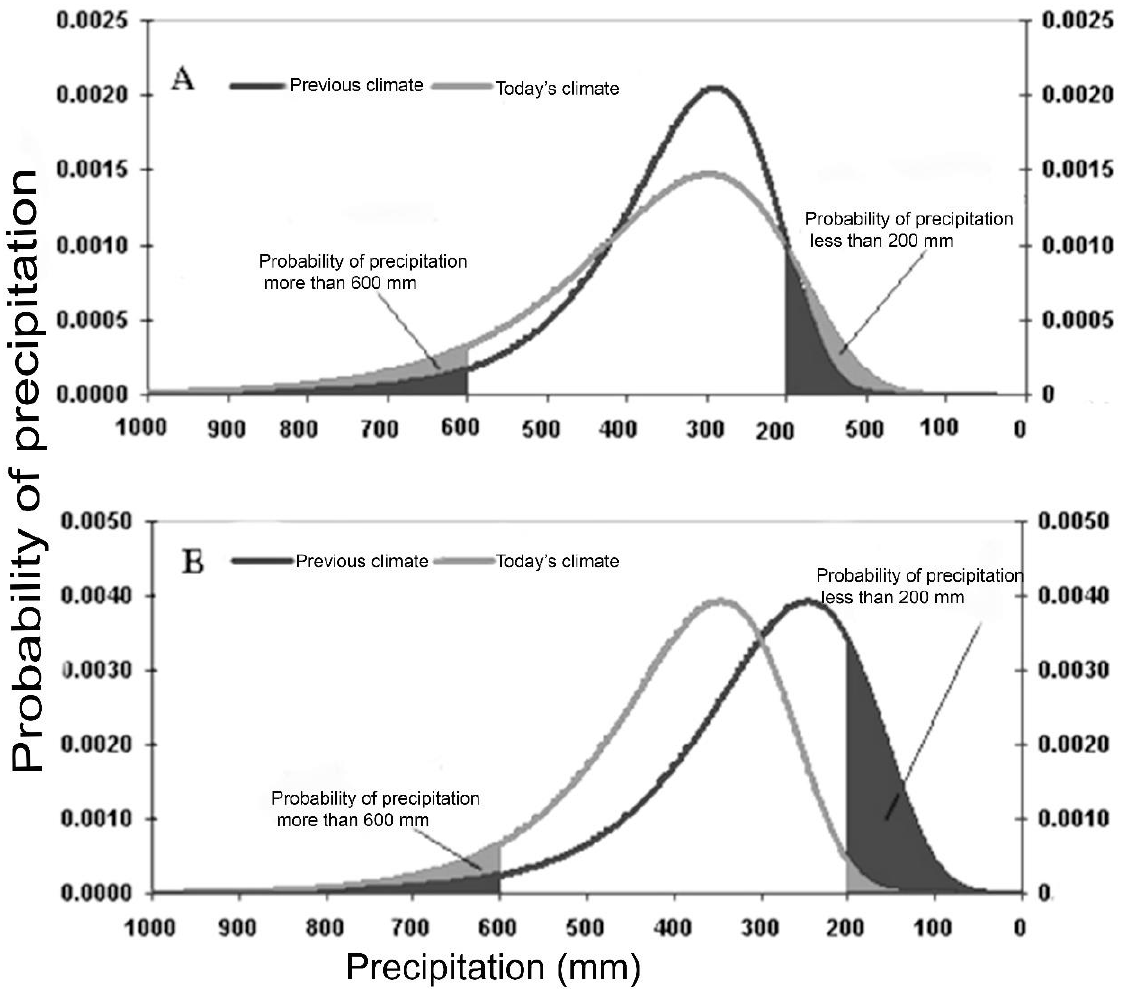
Figure 2. Two different models for Gumbel distribution to compare precipitation changes between two time-periods ( A ): probability of extremely low rains and ( B ): probabilities of extremely high rains.